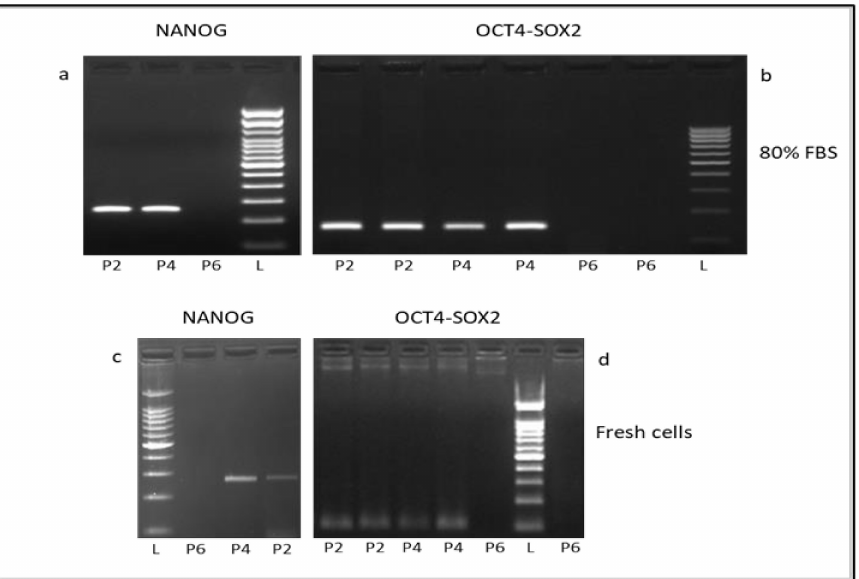
Figure 6. Representative images of expression of pluripotency-associated genes in cells cryopreserved with 10% DMSO and 80% FBS and thawed ( a , b ) and in fresh cells ( c , d ). NANOG (274 bp), OCT4 (141 bp) and SOX2 (142 bp) were expressed in passages P2 and P4 of cryopreserved and fresh cells. The gene expression was not revealed in